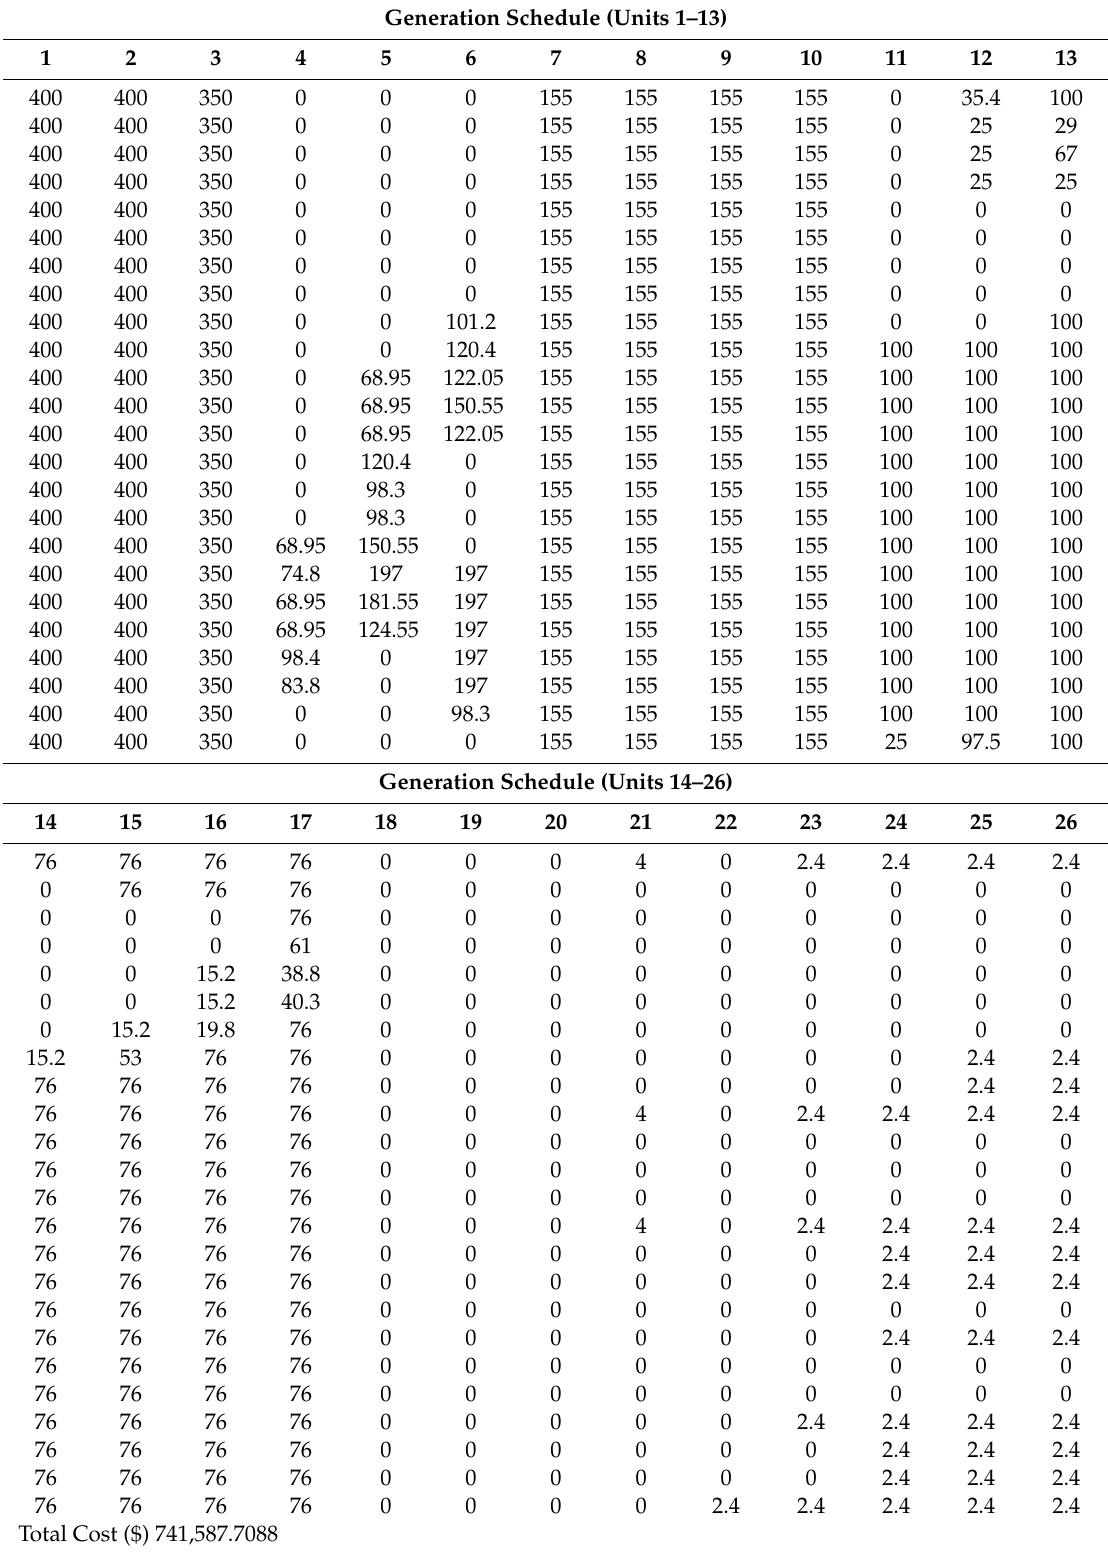
Table 13. Generation schedule of the 26-unit system by